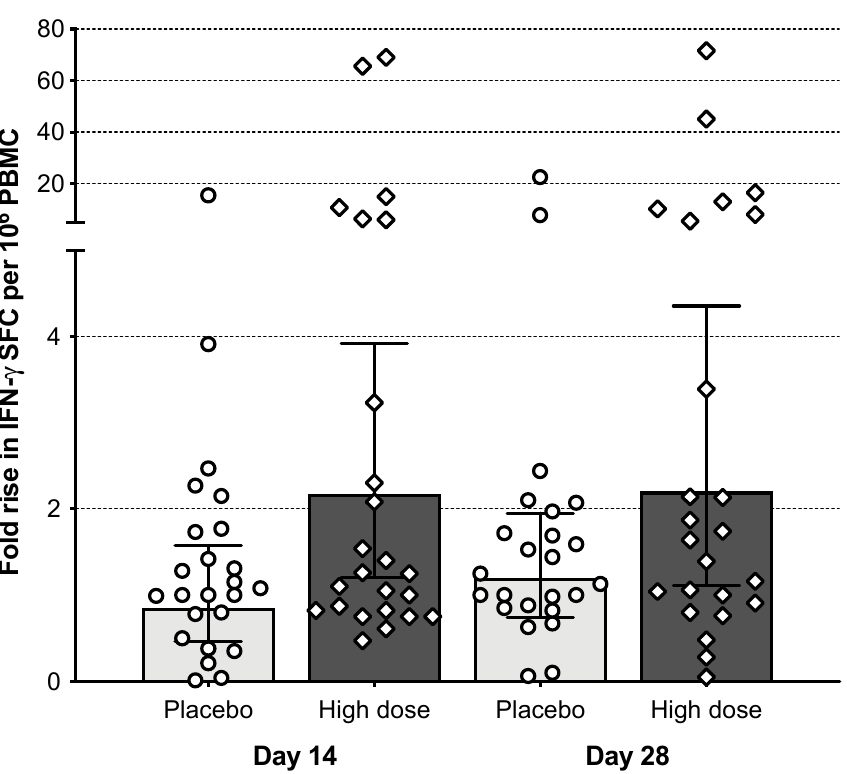
Figure 6. T-cell immune responses. PBMCs collected at baseline and on days 14 and 28 were analyzed by ELISpot assay for the secretion of IFN- γ upon stimulation with influenza-specific class 1 peptides. SFC: spot-forming cells. Bars represent the geometric mean with error bars.